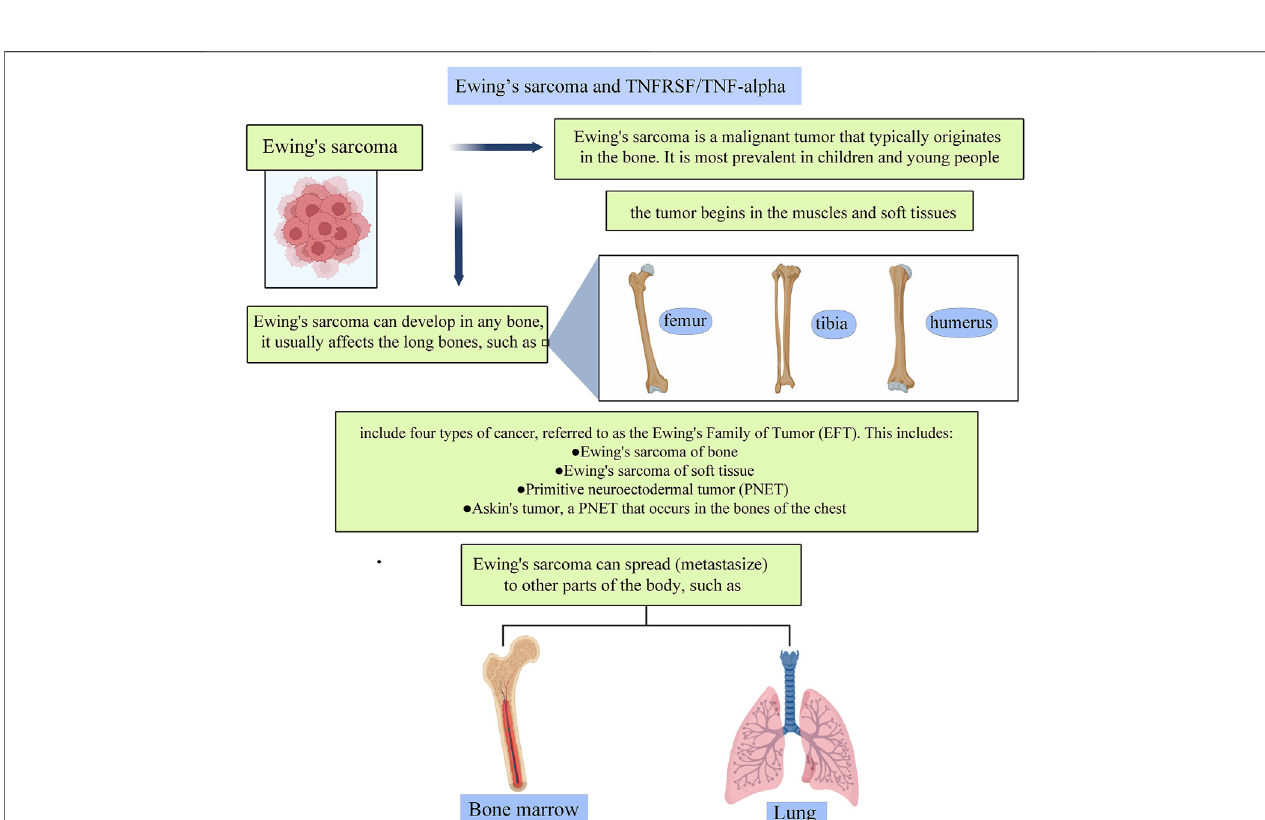
FIGURE 5 | A pictorial description of the relationship between TNFs and TNFRs and their roles in Ewing ’ s sarcoma.